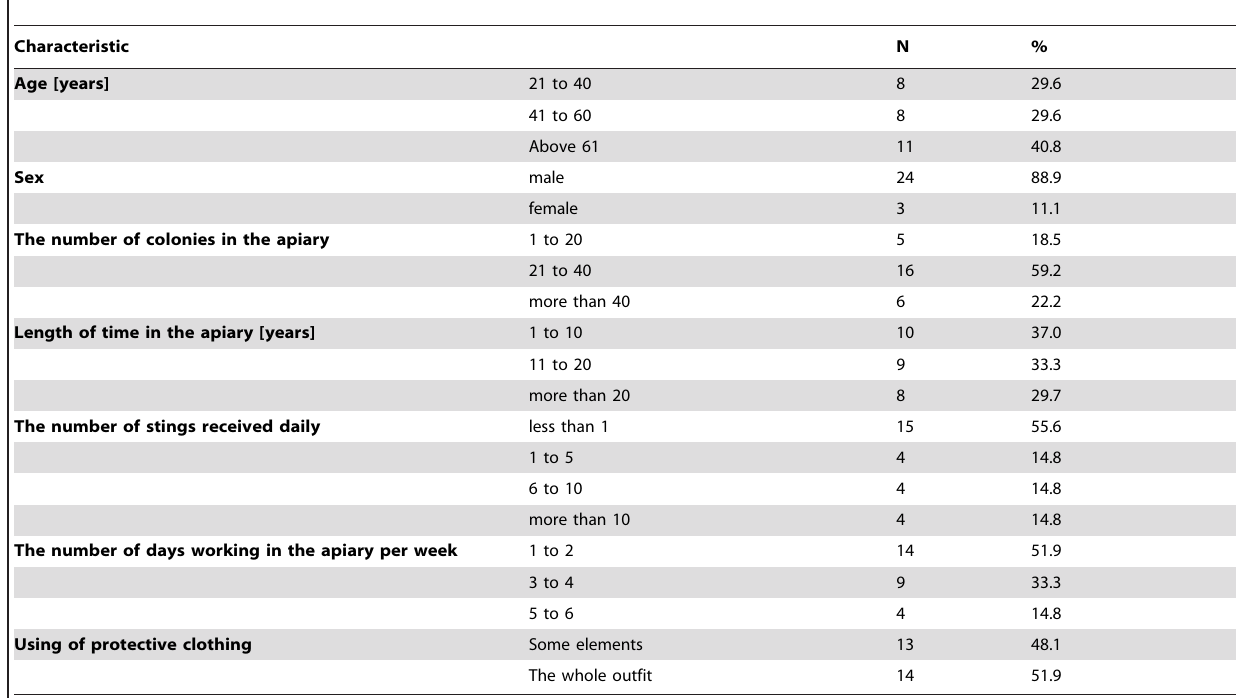
Table 1. Characteristics of the beekeepers involved in the study